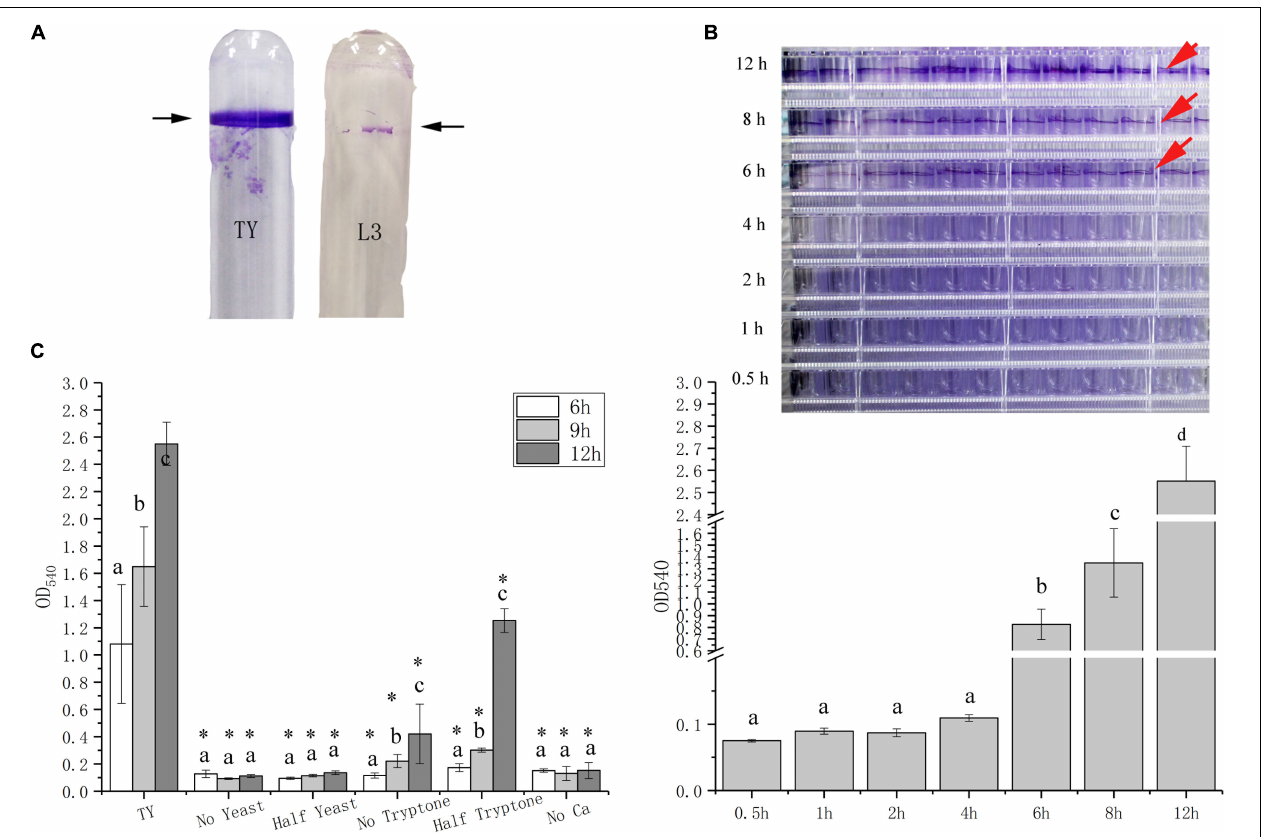
FIGURE 1 | Biofilm formation of Azorhizobium caulinodans at various timepoints with different media components. (A) Biofilm formation of A. caulinodans with TY or L3 medium. Representative images of A. caulinodans biofilm on the wall of glass tubes after culturing for 5 days. (B) A. caulinodans biofilm formation in TY medium from 0.5 to 12 h. Images on the top are representative biofilms on the wall of 96-well plates. (C) Biofilm formation of A. caulinodans after 6, 9, and 12 h, when different components were removed from TY medium. Values are shown as the means and standard deviations from at least three independent experiments. The same letter above the error bars indicates not statistically different with results after culturing for 0.5 h (B) or under same conditions (C) by a Duncan’s test. Asterisks ( ∗ ) means P < 0.05 vs. the results after same time with TY medium by a Student’s t